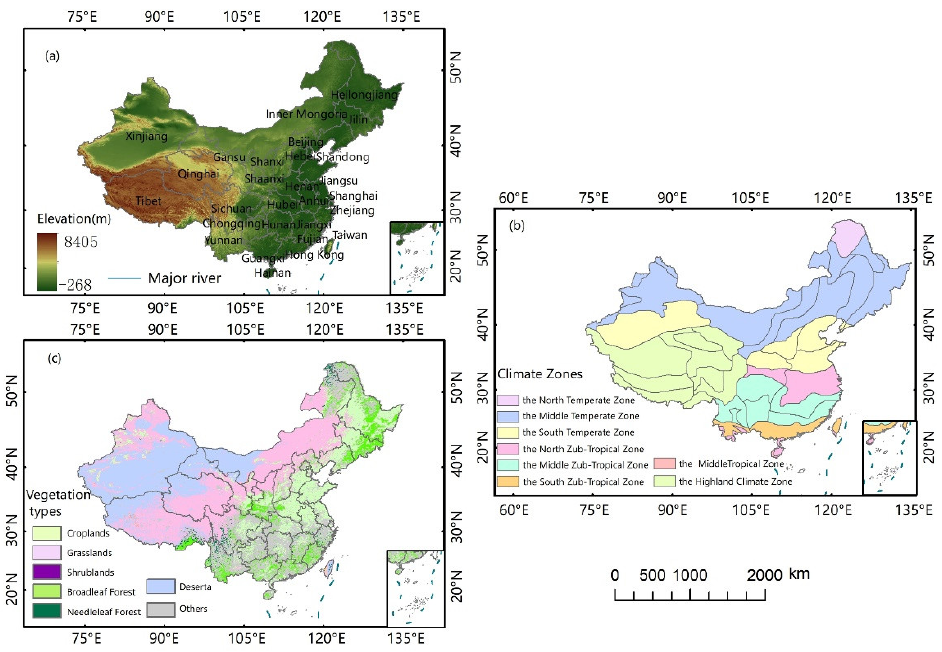
Figure 1. Geographical features of China: ( a ) geographical settings with elevation information; ( b ) climate zones; ( c ) vegetation types.